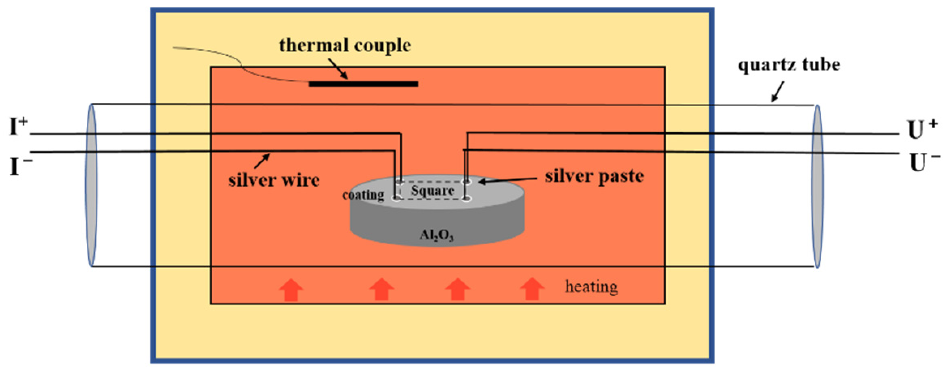
Figure 2. Illustration of the conductivity measurements setup.